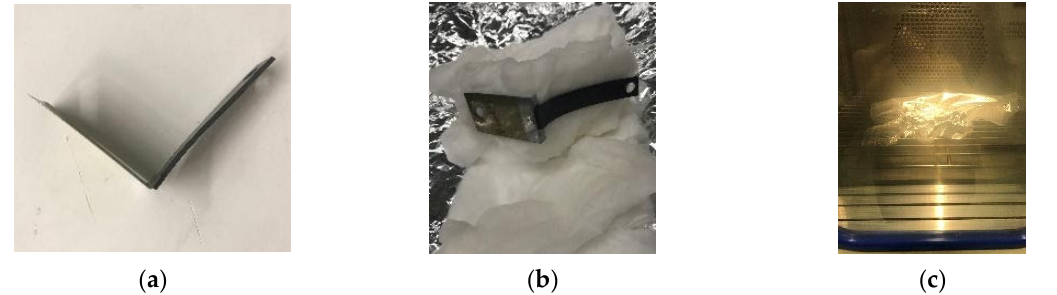
Figure 18. Preparation of specimen: ( a ) specimen bond of cyanoacrylate between rubber and sheet metal; ( b ) specimen in wet cotton and aluminium foil; ( c ) vacuum packed specimen in climatic chamber).